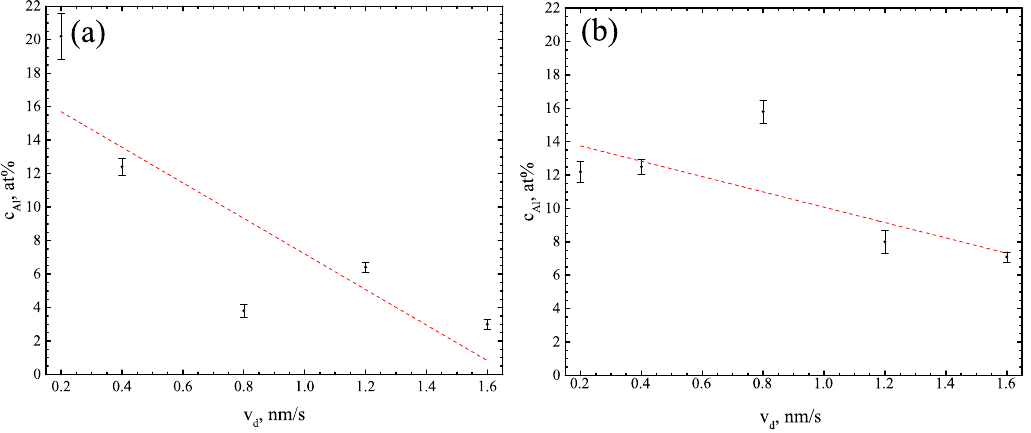
Figure 2. Aluminum concentration in 6ScAlSZ thin films: ( a ) T d = 300 °C and ( b ) T d = 600 °C.